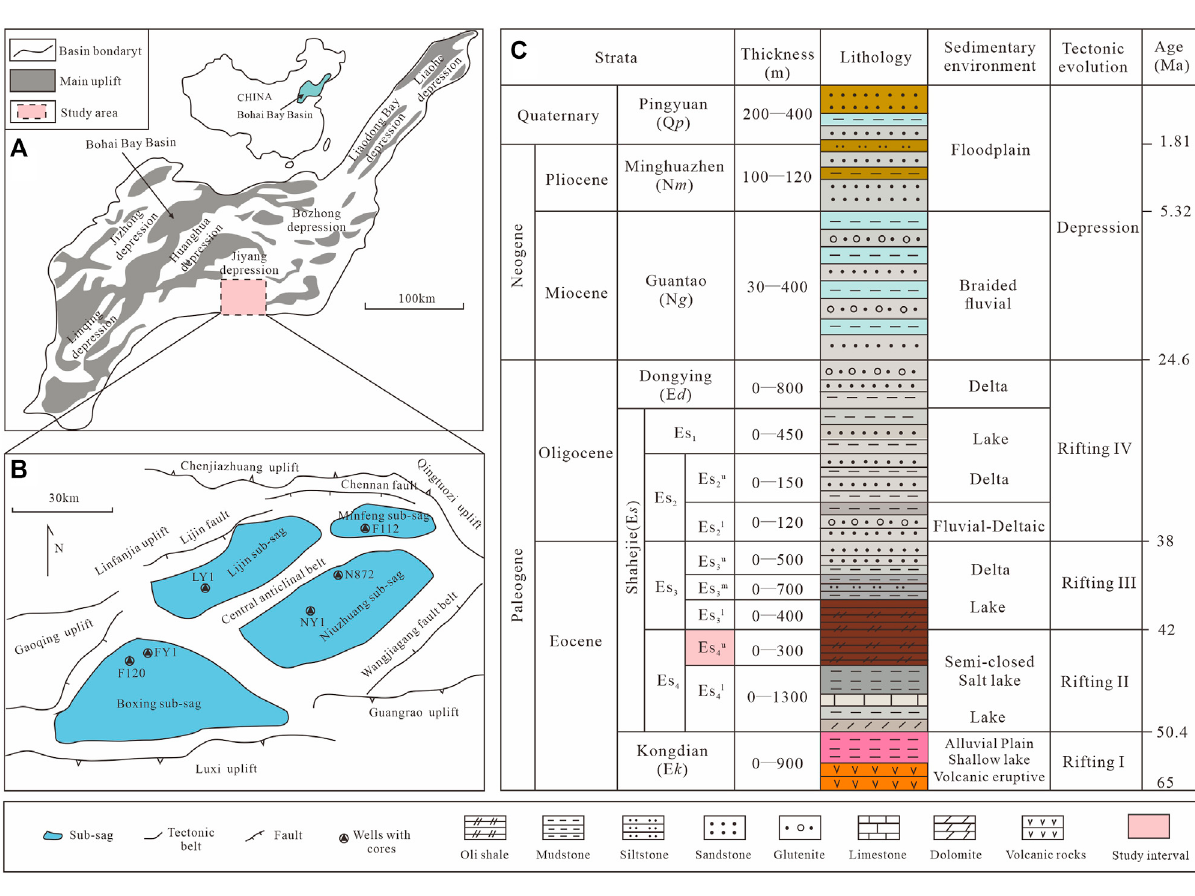
FIGURE 1 Location map (A) , structural map and key well locations of the Dongying Sag, (B) and its stratigraphic column (C)